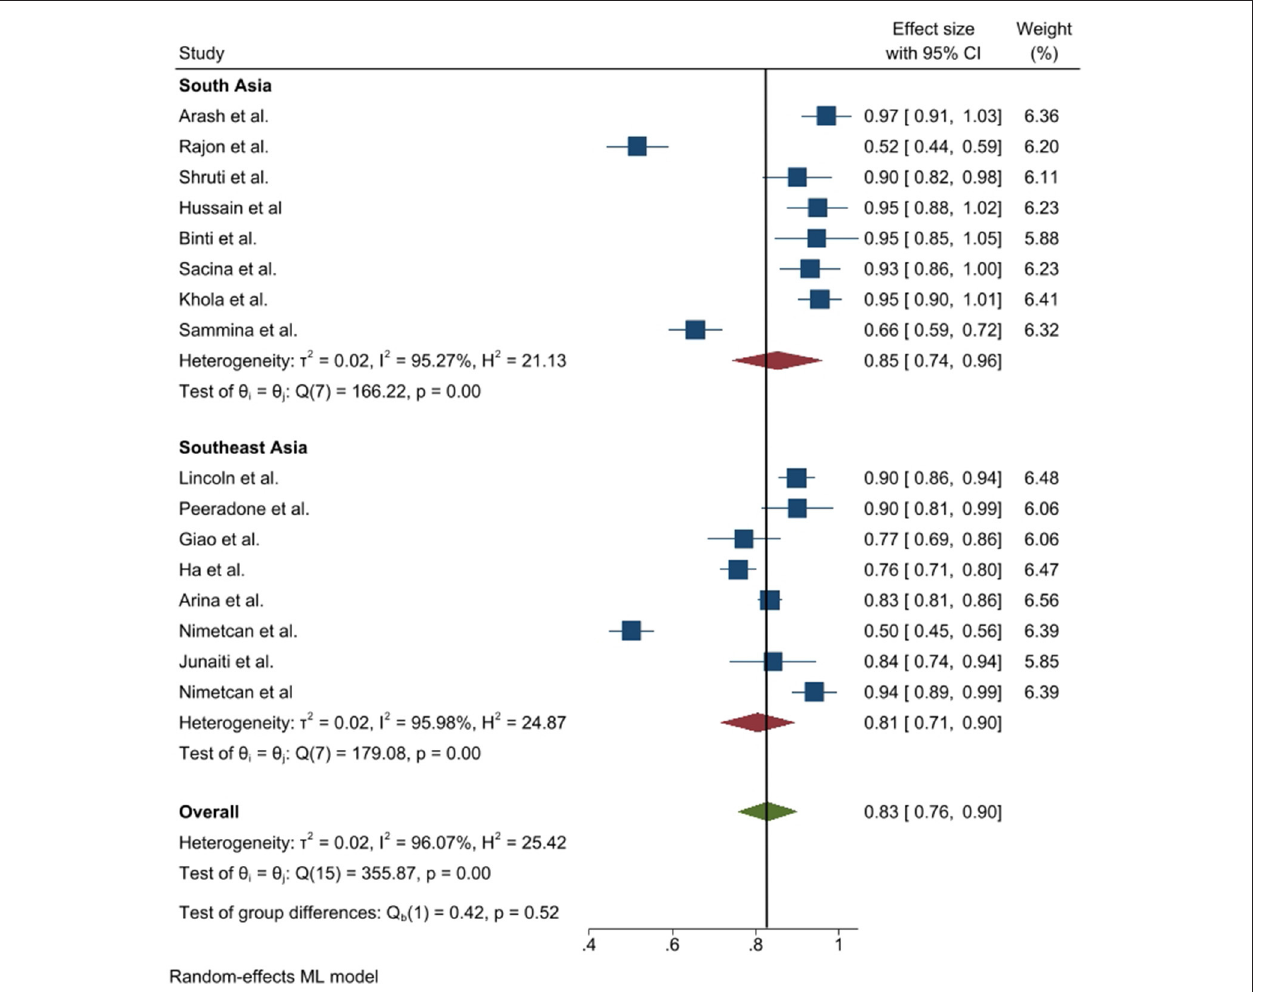
FIGURE 6 | Prevalence of frequent practice toward COVID-19 epidemic in Southeast and South Asia, stratified by